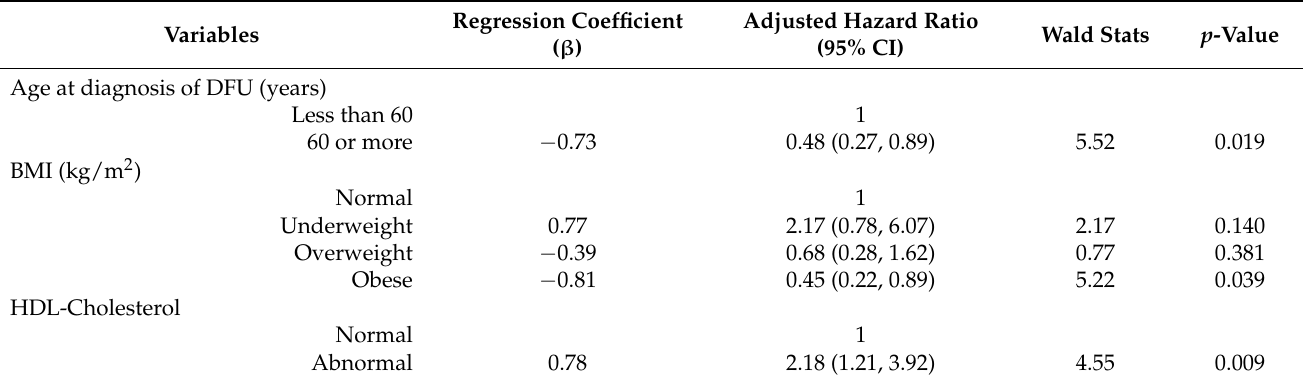
Table 3. The Final Model for Prognostic Factors of LLA among DFU